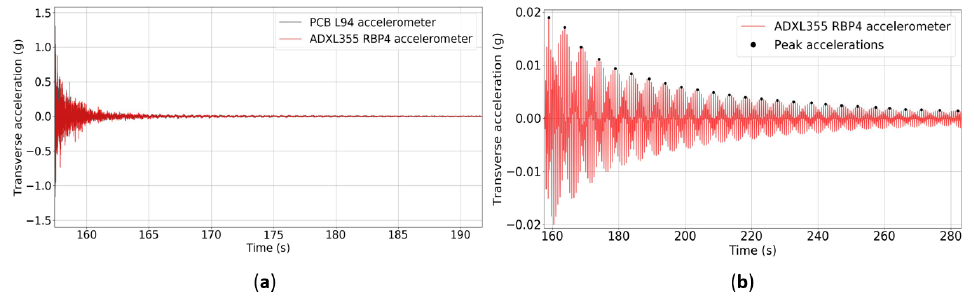
Figure 33. Transverse free-vibration response of the steel structure for DOF 4: ( a ) Exponential free- decay window. ( b ) Representative acceleration peaks from the filtered free-vibration signal of the ADXL355 RBP4 accelerometer. Table 11. Mean damping ratios and coefficients of variation calculated for both monitoring